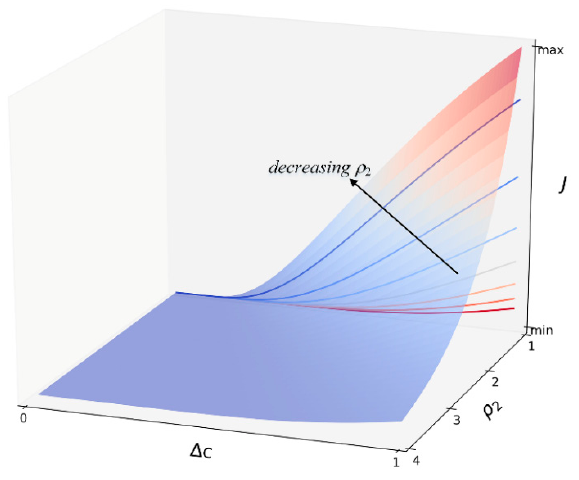
Figure 1. Schematic diagram of the e ff ects of undercooling ∆ c and parameter ρ 2 on the nucleation rate. In non-isothermal case, ρ 3 = ∆ S a / ( ∆ [ µ 1 − µ 2 ]) , reflecting the influence of temperature. µ 1 and µ 2 are the chemical potentials of the solvent and solute, and ∆ S a is the transformation entropy change.